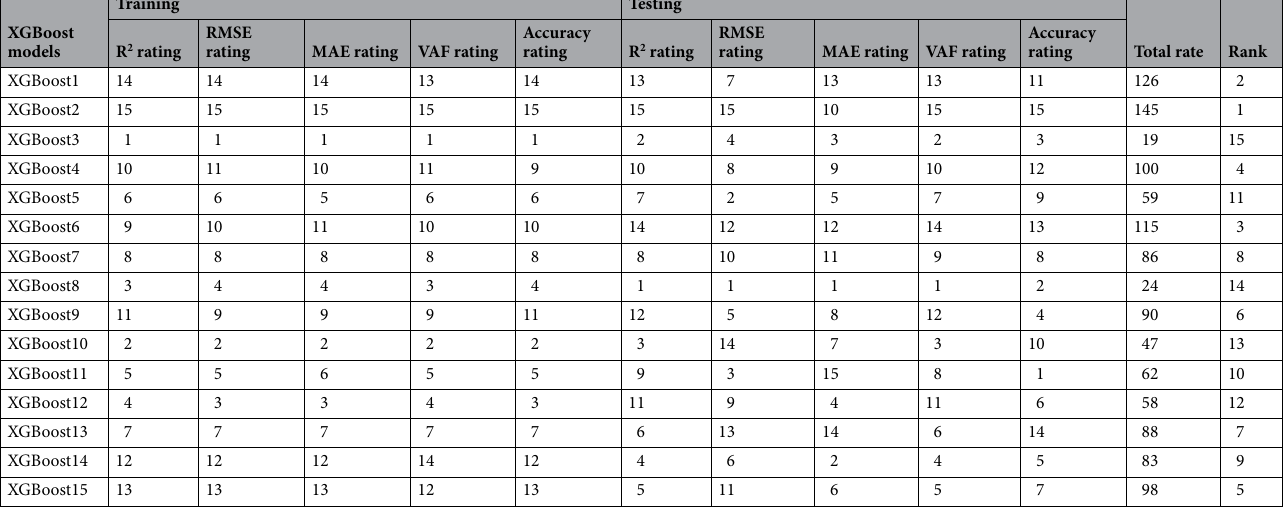
Table 7. Performance of the base models of XGBoost and their